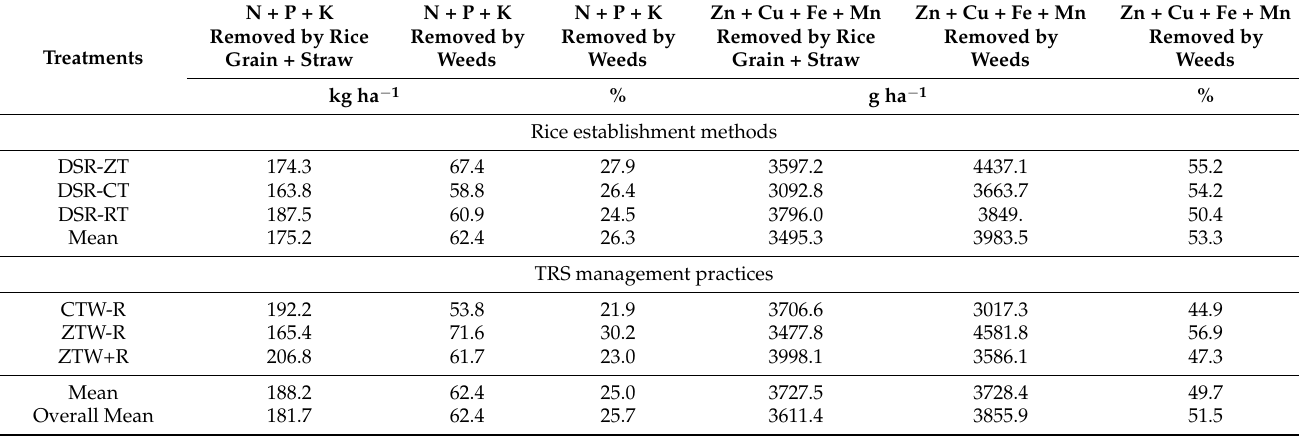
Table 7. Nutrients removal by rice grain + straw and weed biomass and budgeting under different rice establishment methods. N + P + K Removed by Treatments